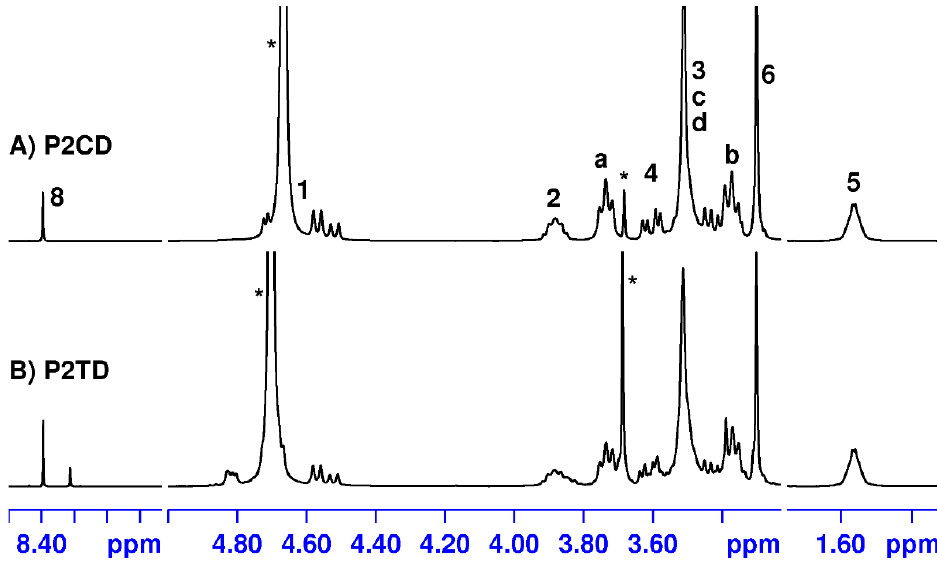
Figure 4. 1 H NMR spectra of the deprotected polymers P2CD and P2TD recorded in deuterium oxide. Signals marked with an asterisk correspond to solvents.